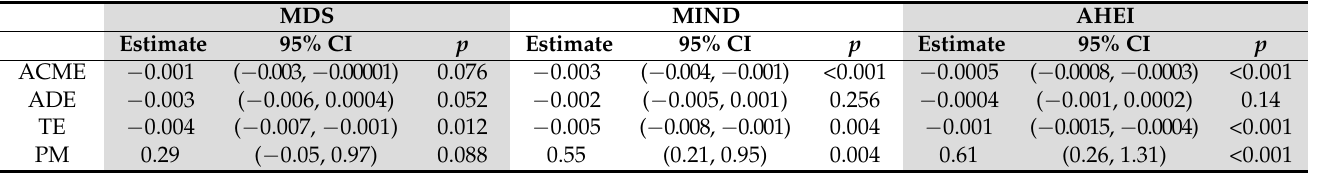
Figure 2. Metabolites selected to create metabolomic diet score. ( A ) Using elastic net regression, 10, 41, and 59 metabolites were selected to create a metabolomic diet score (metDS) for MDS, MIND, and AHEI, respectively. There were 4 metabolites common to all three dietary patterns, 19 metabolites associated with two dietary patterns, and 60 metabolites unique to individual dietary pattern score. The metDS showed moderate associations with the measured diet scores, with a correlation of 0.42 for MDS ( B ), 0.49 for MIND ( C ), and 0.56 for AHEI ( D ). Table 2. Results of mediation analysis of metabolomic diet score on the association between diet and frailty